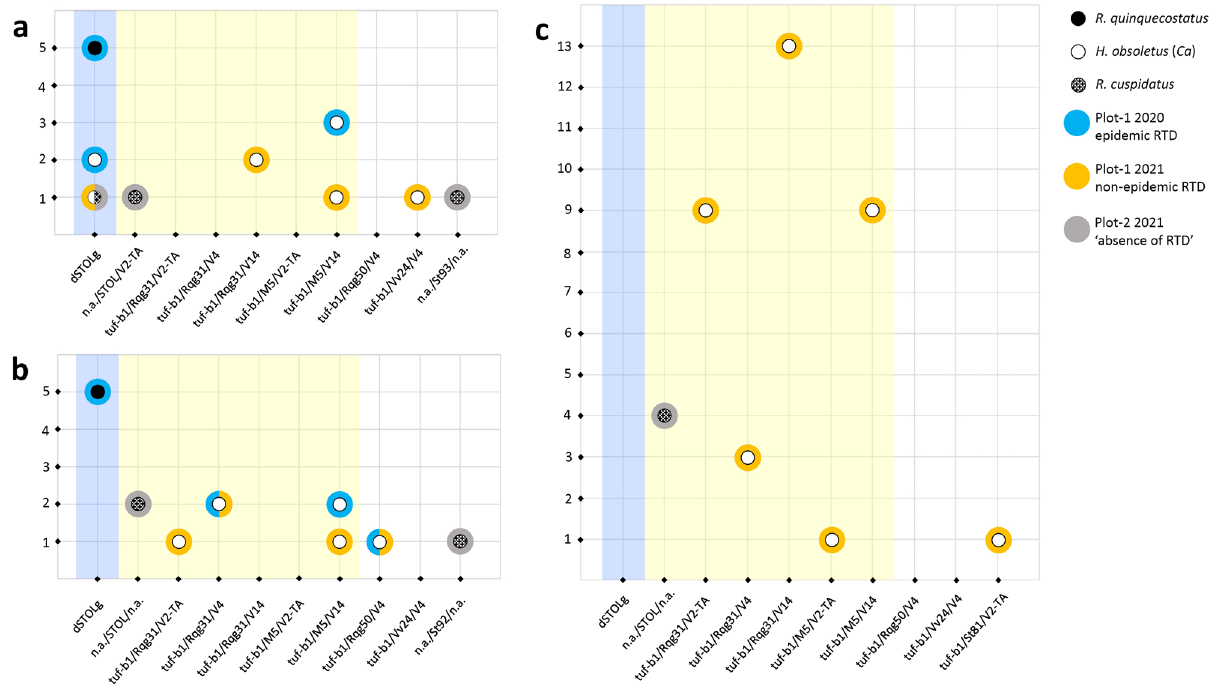
Figure 4. Scatter plot of the CaPsol strains transmitted to experimental plants by the three cixiid species: R. quinquecostatus sensu Holzinger et al . 15 , H. obsoletus ( Ca ) and R. cuspidatus. ( a ) individual sugar beets; ( b ) individual periwinkles; ( c ) sugar beets in semi-field cage experiments. CaPsol multilocus genotypes transmitted to experimental plants are labeled on the x-axis, while the number of infected test plants is labeled on the y-axis. Each of the three vectors is represented by a circle as described in the legend. A colored halos correspond to specific RTD severity, i.e., where and when vector populations were sampled. The blue background highlights dSTOLg, the CaPsol strain predominating in RTD-affected sugar beets in 2020 epidemic RTD occurrence, while the yellow encompasses CaPsol strains prevailing in RTD-affected sugar beets the 2021 non-epidemic disease